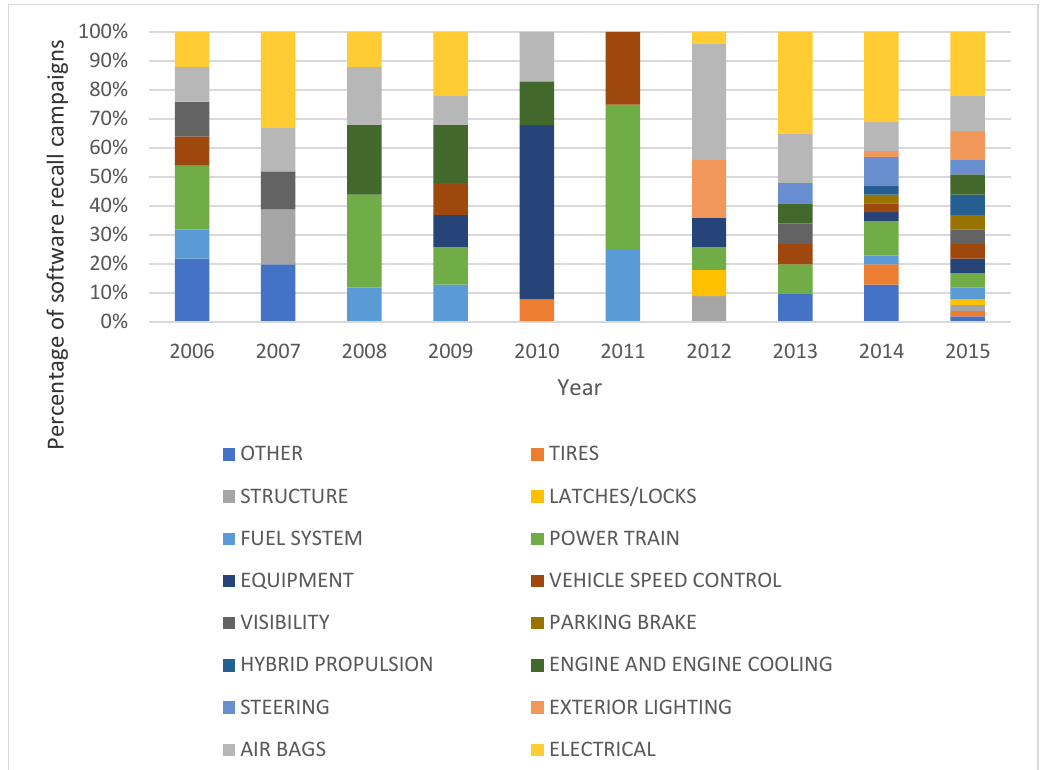
Figure 4 Percentage of software recall campaigns according ECU software (years